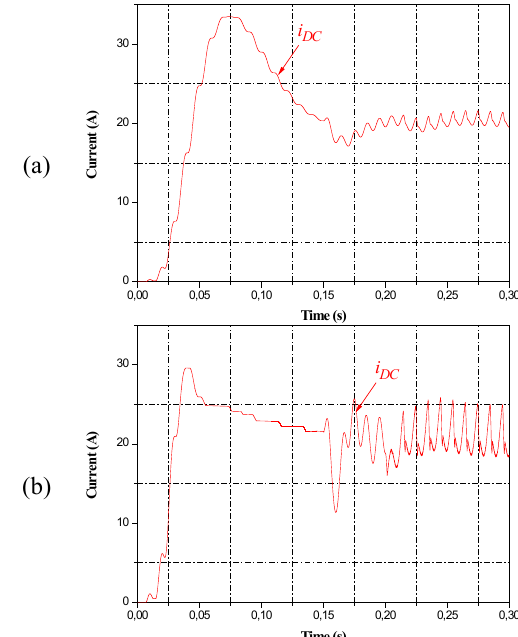
Figure 4. Simulation results of dc-link current, i DC , regulation: (a) Conventional SAPF;(b) SAPF with reduced dc-link.